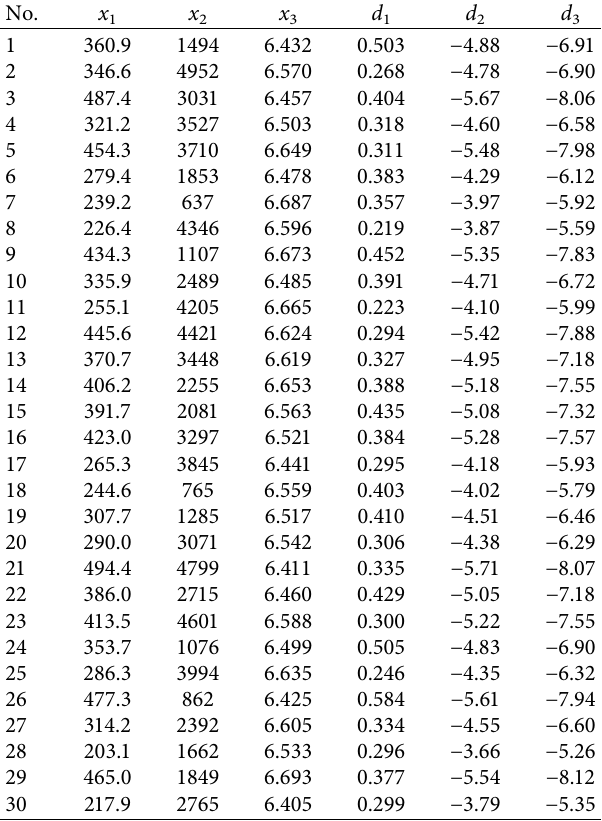
Table 2: LHS and its response values of the design parameters of the KLK2 high-speed